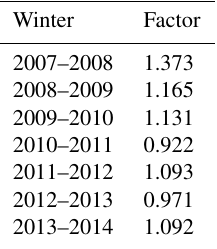
Table 2. Scaling factors required to match measured snowfall to measured snow accumulation